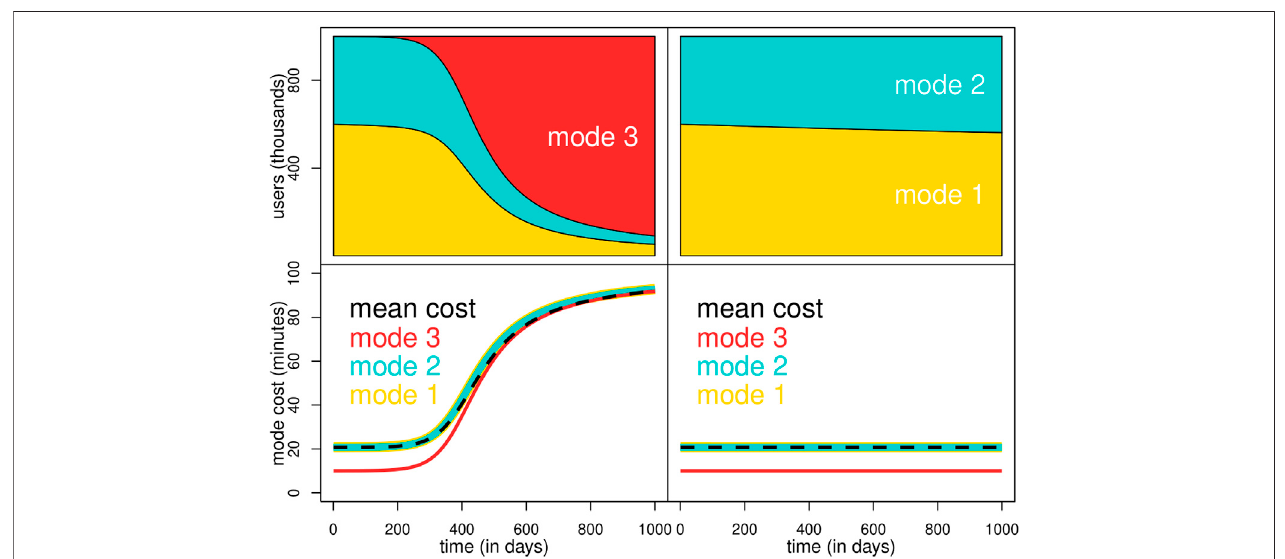
FIGURE 7 | Modal share (top) and commuting time in minutes (bottom) as the dynamical system evolves in some dimensionless units, marked as “ days ” . The top left panel has a small (positive) initial number of users for mode 3. The right panel has zero initial users for mode 3, resembling the scenario where that mode will never exist. The baseline commuting time of mode 3 is below the observed commuting time for modes 1 and 2, so the red line has a lower cost than the initial condition. As moreusersareattractedbythefastermode3,thismodebecomesslower,butalso,othermodesexperiencehigherinducedcosts.Onlyifalluserspickmode3,the commuting time of all modes is the same (thus becoming an equilibrium). Otherwise, the commuting time is always lower for mode 3. The average commuting time (dashed line) increases when mode 3 attracts more users. With these parameters, regardless of the initial internal conditions, the long-term distribution is that everyone choosesmode3.However,when x 3 ( t )=0(rightpanel),thesystemconvergestoaseparateequilibrium,wherethelong-termmeancommutingtimeissigni fi